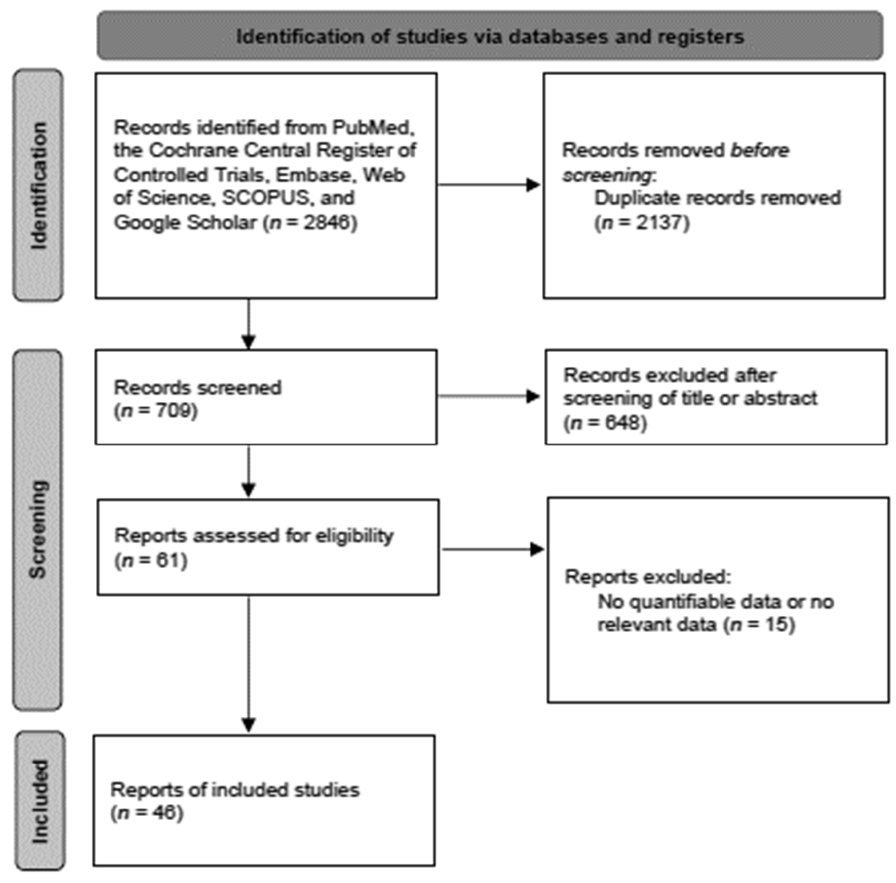
Figure 1. Diagram of selection of studies.